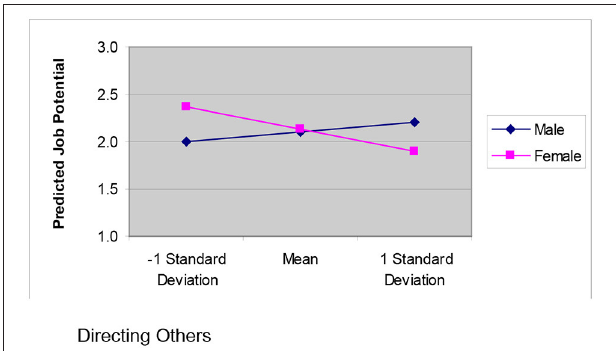
FIGURE 2 | Interactive effects of the directing others leadership competencies on